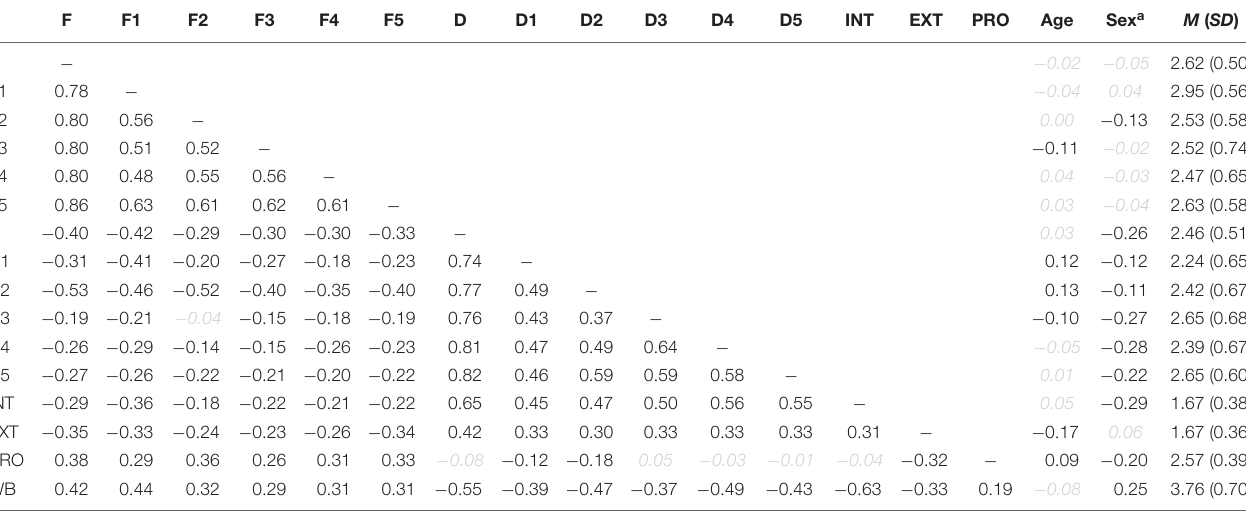
TABLE 2 | Inter-correlations, means, and standard deviations of study variables: emotion regulation, psychosocial adjustment, well-being, age, and